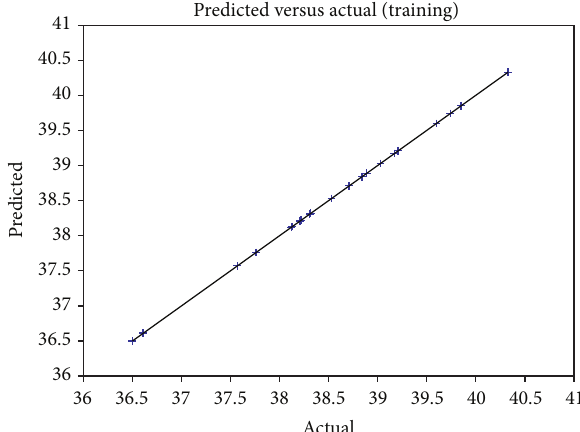
Figure 2: Comparison between predicted values and actual values during training process.